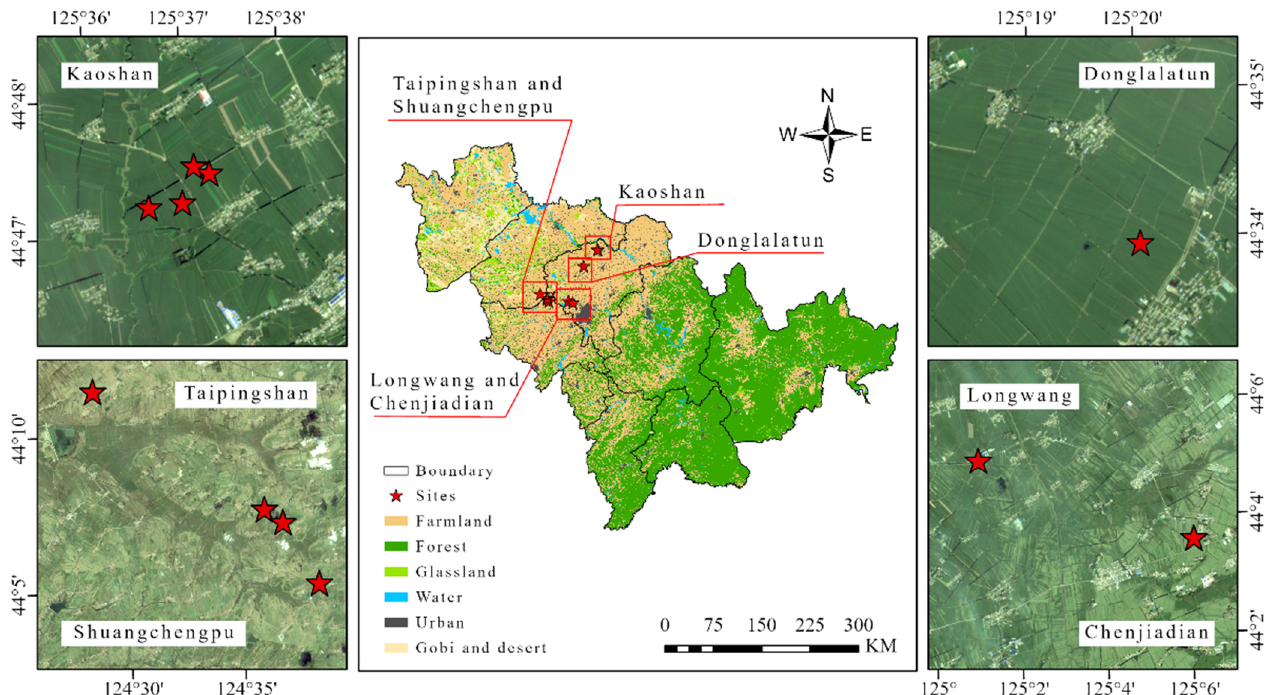
Figure 1. The locations of 11 sites in two study areas in Nong’an and Changling Counties. The main crop on the farmland is maize. The remote sensing images for September 2021 are from Sentinel 2A and the land cover datasets for 2015 are from the Resource and Environment Science and Data Center, Chinese Academy of Sciences.